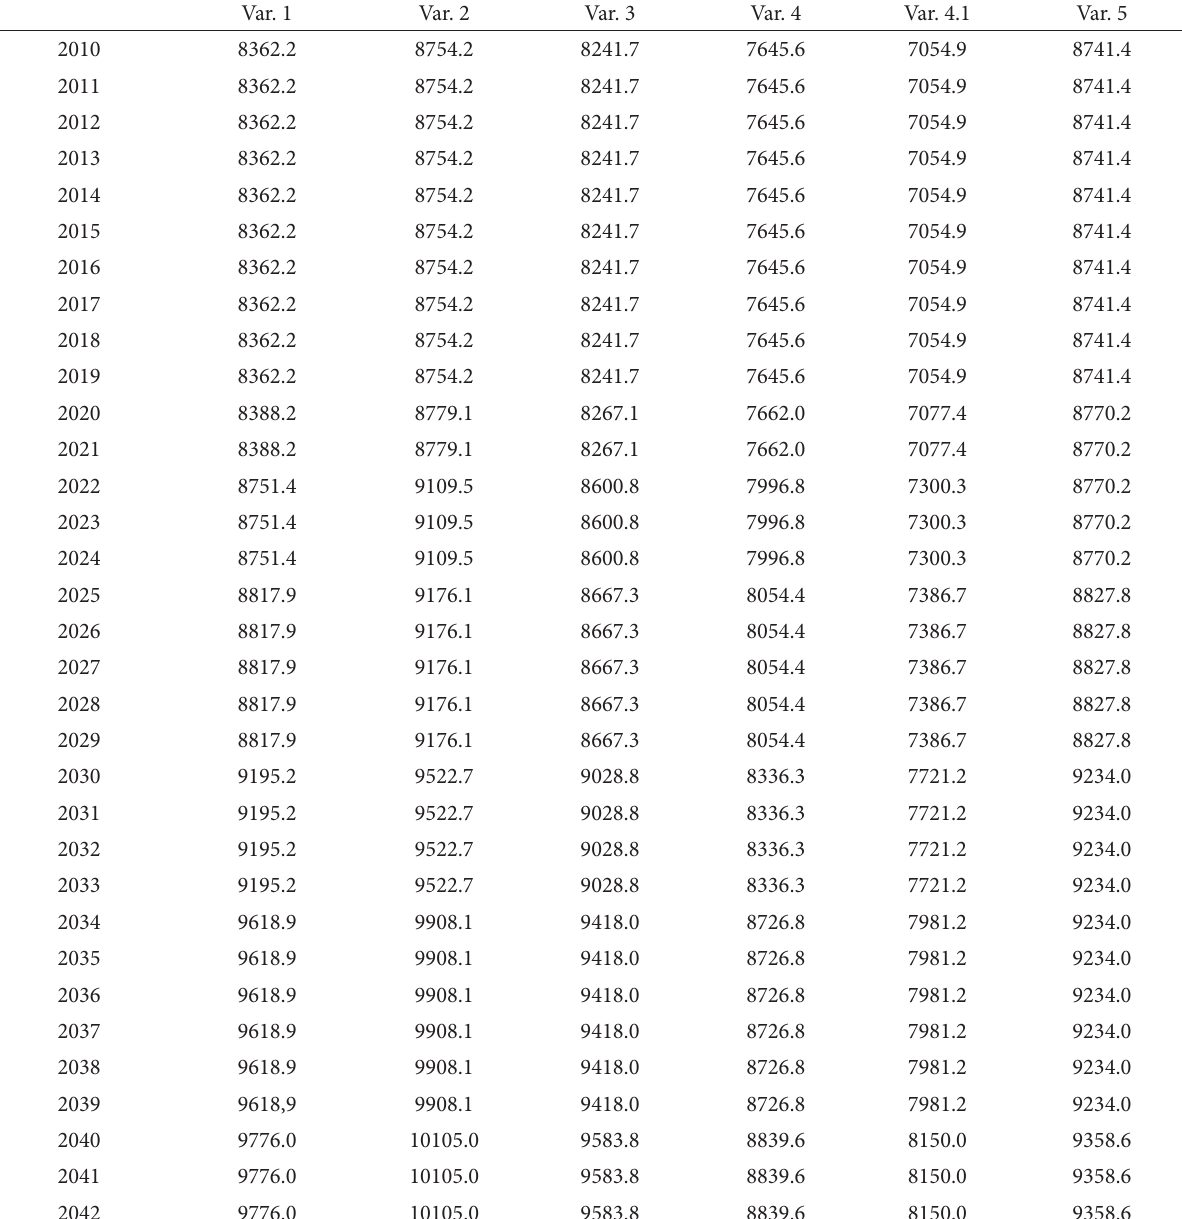
Fig. 15. Graph – trends of the LCC costs development (thousands EUR) of variants – part II Table 2. Cumulated costs (thousands EUR) of all variants for the period of 50 years (in current prices) Var. 1 Var.